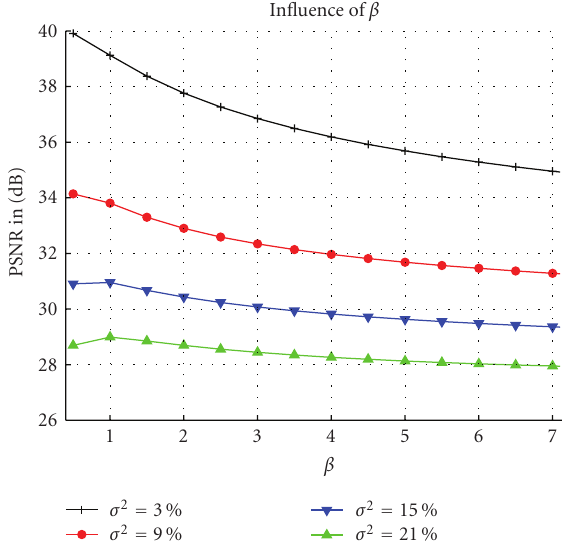
Figure 4: Influence of the filtering parameter 2 β (cid:2) σ 2 on the PSNR according to β and for several levels of noise. These results are ob- tained with the optimized blockwise NL-means filter on the T1-w phantom MRI and account for the error in the estimation of σ